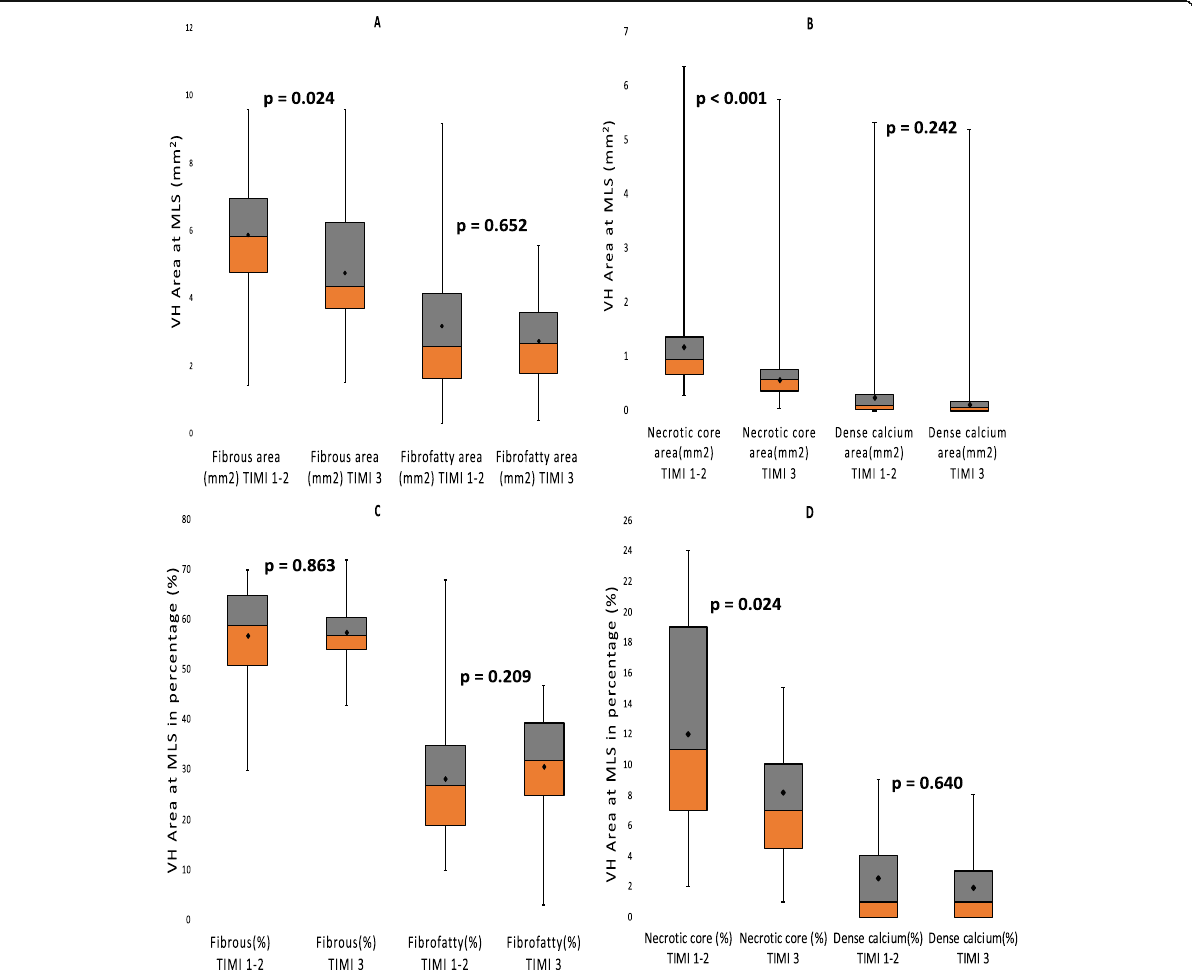
Fig. 1 The virtual histology plaque components in TIMI 1 – 2 and TIMI 3 groups at the minimum lumen area site (MLS). a and b represents the absolute plaque components and c and d represents the relative plaque components at the